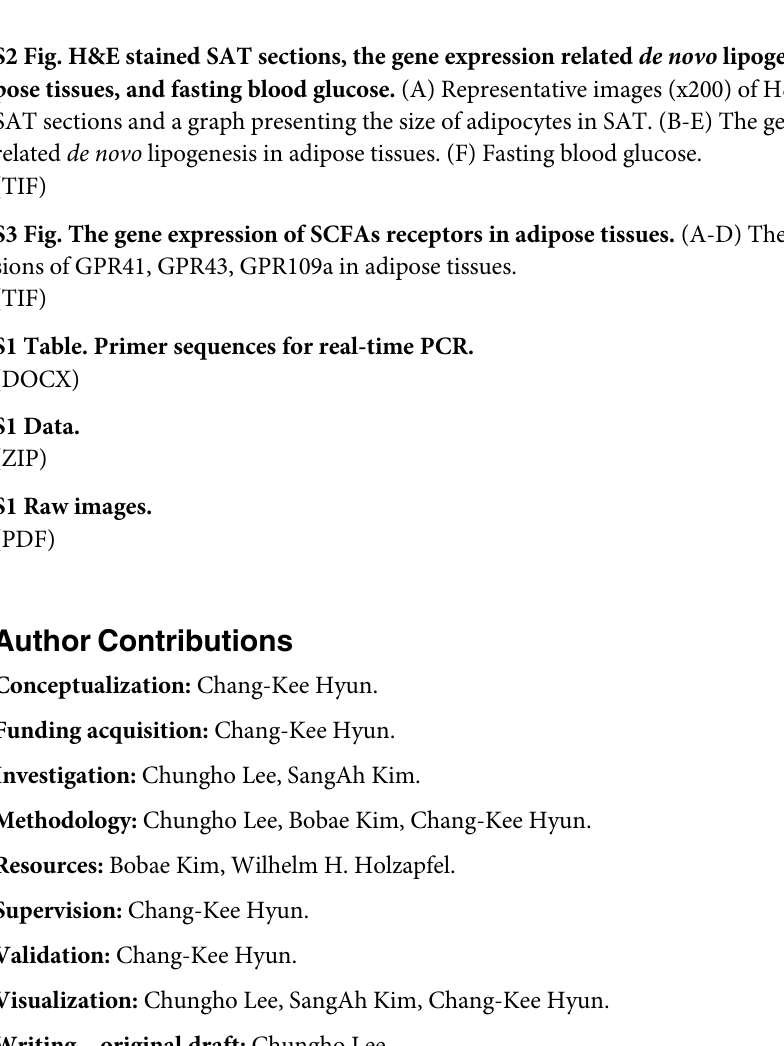
S2 Fig. H&E stained SAT sections, the gene expression related de novo lipogenesi s in adi- pose tissues, and fasting blood glucose. (A) Representative images (x200) of H&E stained SAT sections and a graph presenting the size of adipocytes in SAT. (B-E) The gene expressions related de novo lipogenesis in adipose tissues. (F) Fasting blood glucose. (TIF) S3 Fig. The gene expression of SCFAs receptors in adipose tissues. (A-D) The gene expres- sions of GPR41, GPR43, GPR109a in adipose tissues. (TIF) S1 Table. Primer sequences for real-time PCR. (DOCX) S1 Data. (ZIP) S1 Raw images.